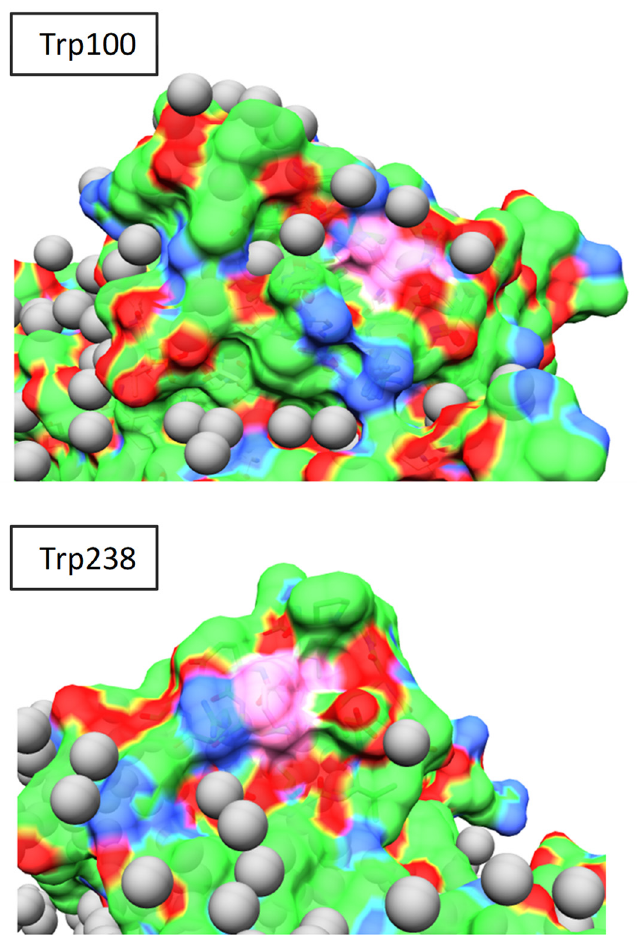
Figure 7. Exposed surface of Lm PTR1 (PDB ID: 1E92). Colour code of surface atoms: C, green; N, blue; O, red; C atoms of Trp100 and Trp238, pink; O atoms of crystal water molecules, grey.